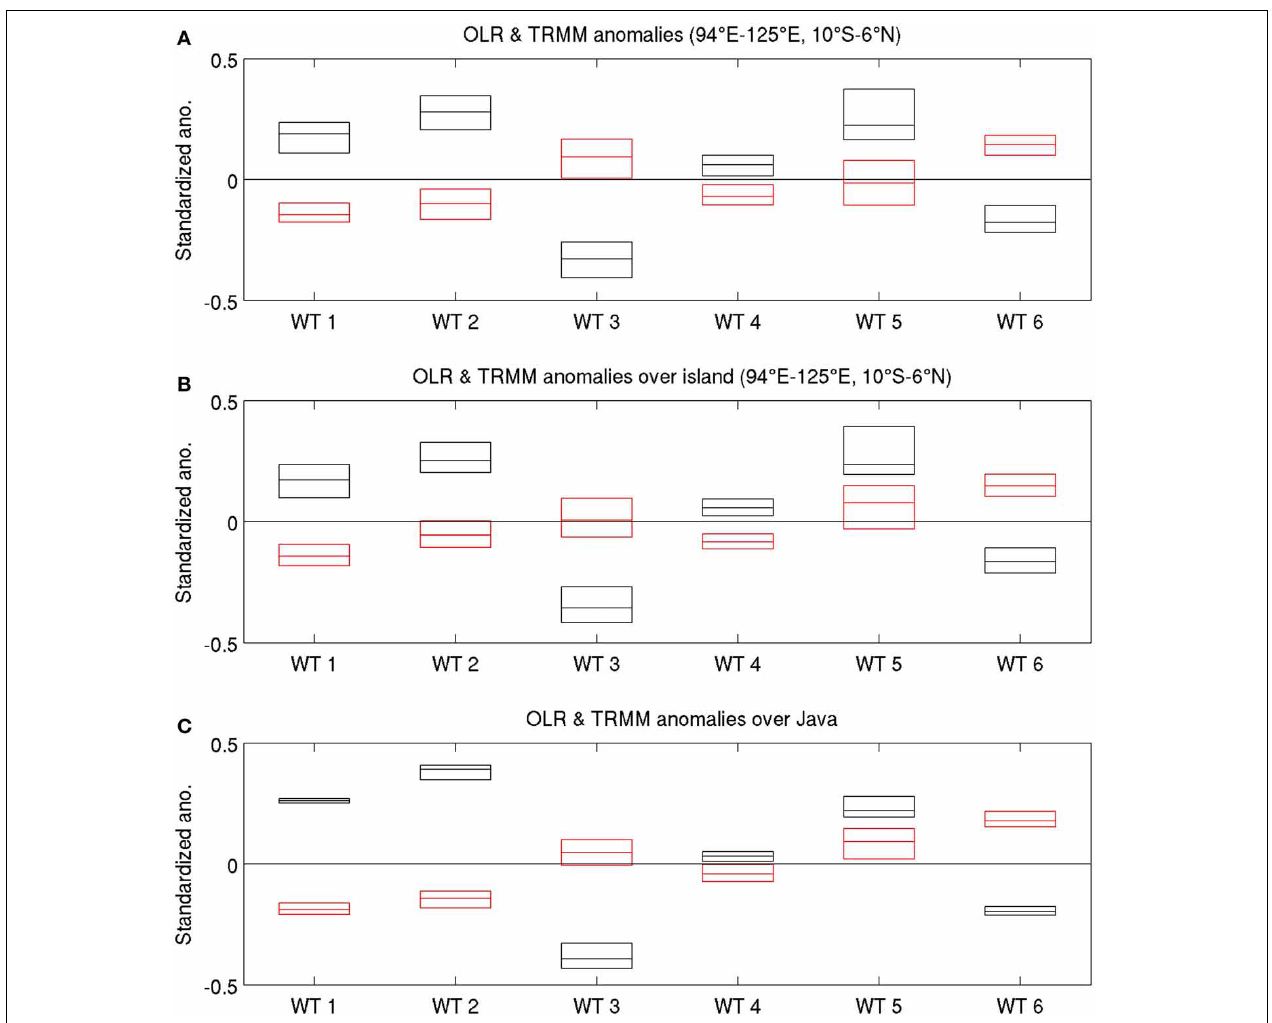
FIGURE 10 | OLR (black) and TRMM rainfall (red) standardized anomalies relative to the mean seasonal cycle for each WT, from 1998/1999 on only. Daily rainfall values (in 1 / 10mm/day) are cube-rooted before the computation of climatological mean and anomalies;